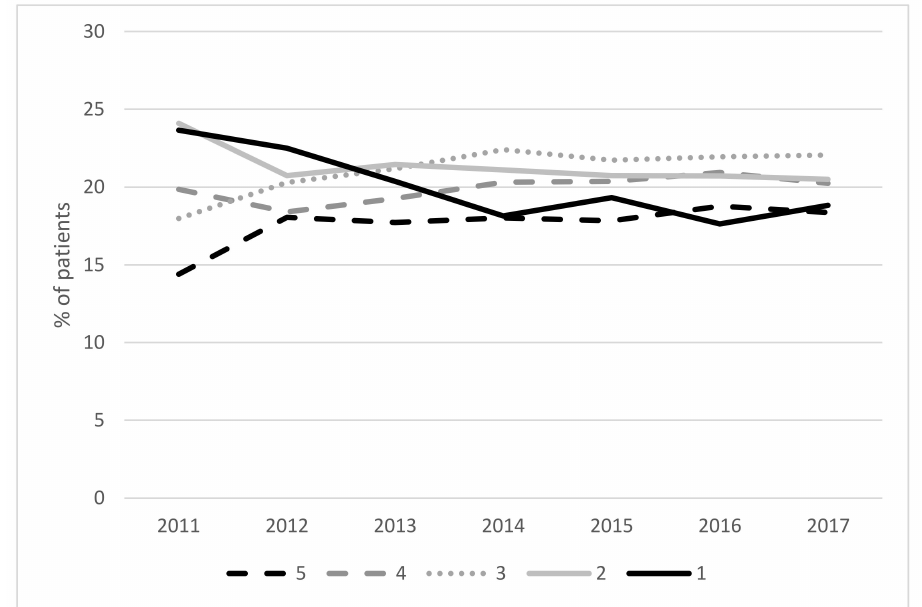
Figure 3. Generic pathway referrals according to socioeconomic groups between 2011 and 2017 (5 = lowest deprivation, 1 = highest deprivation) ( N = 76,628